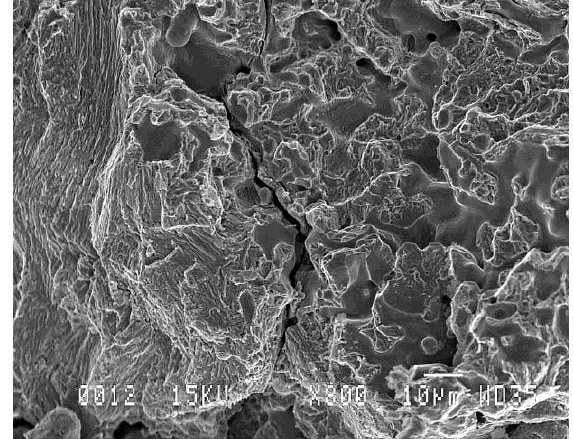
Figure 13. SEM micrograph of the fracture surface of the admixed PM steel at R = 0.5. A secondary crack has passed through a sinter neck.